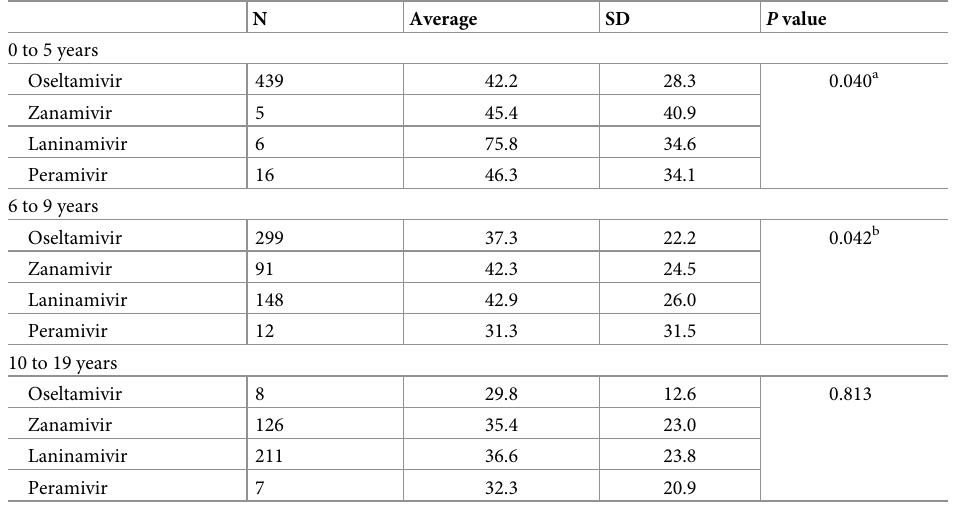
Table 5. Sub-group analysis of fever duration for four NAIs by age group.